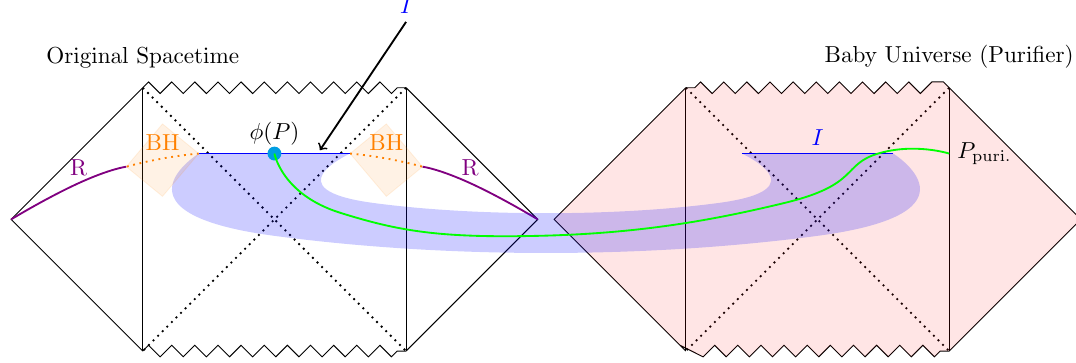
Figure 4 . Schematic picture of the geometry of the AdS black hole coupled the bath CFT (left Pen- rose diagram) and their copy (right Penrose diagram) connected to the original spacetime through the wormhole (blue region), corresponding to the state (2.14). The local operator φ in the island (cyan dot) can be gravitationally dressed with a gravitational Wilson line W gravity ( P, P puri. ) (green line) which ends on the baby universe (right Penrose diagram) without intersecting the entangle- ment wedge of the original black hole degrees of freedom (orange shaded